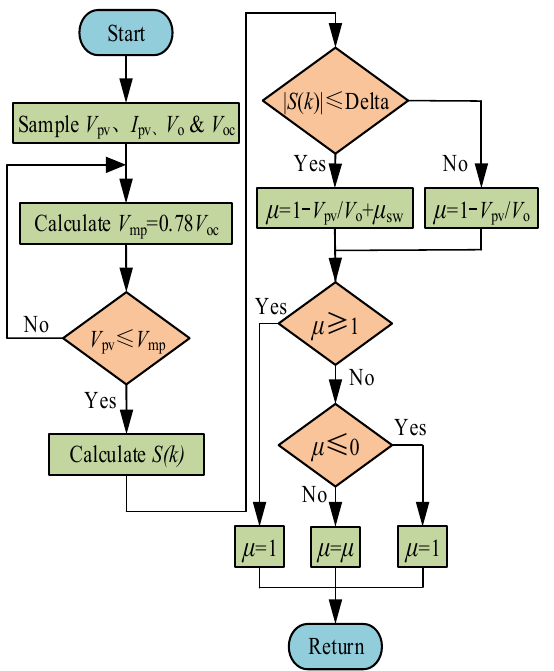
Figure 11. Improved SMC algorithm flowchart.